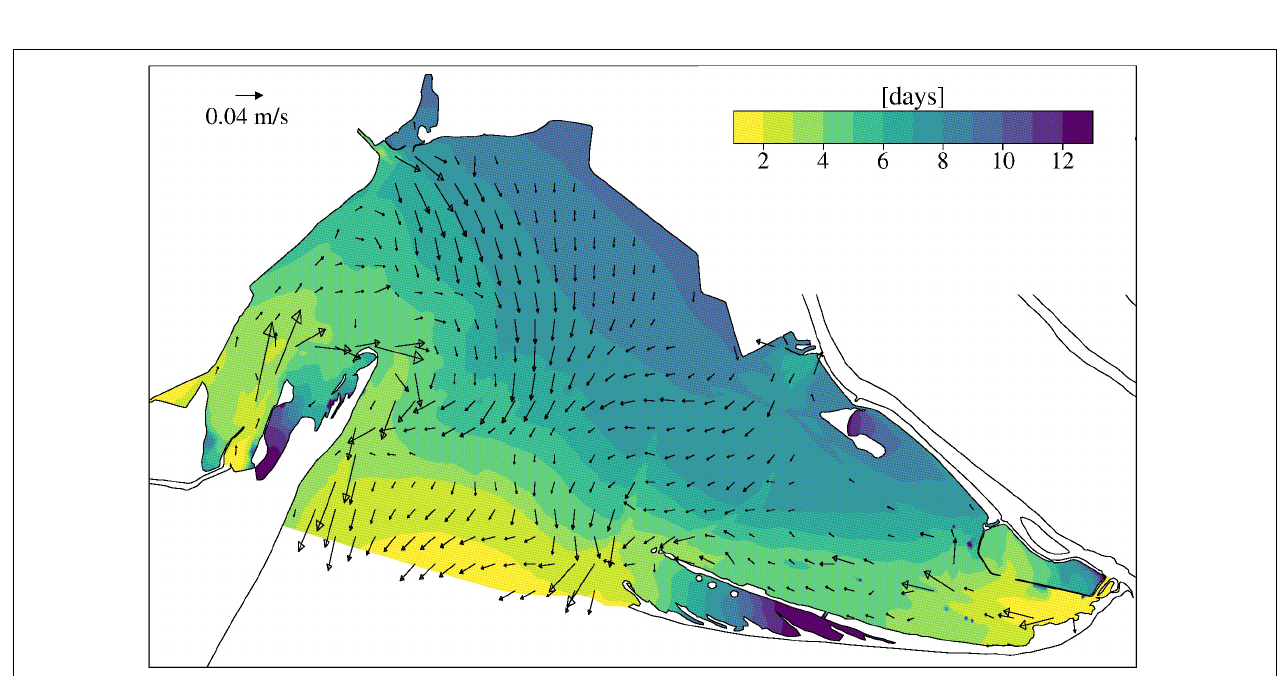
FIGURE 7 | Average water renewal time and surface circulation calculated in